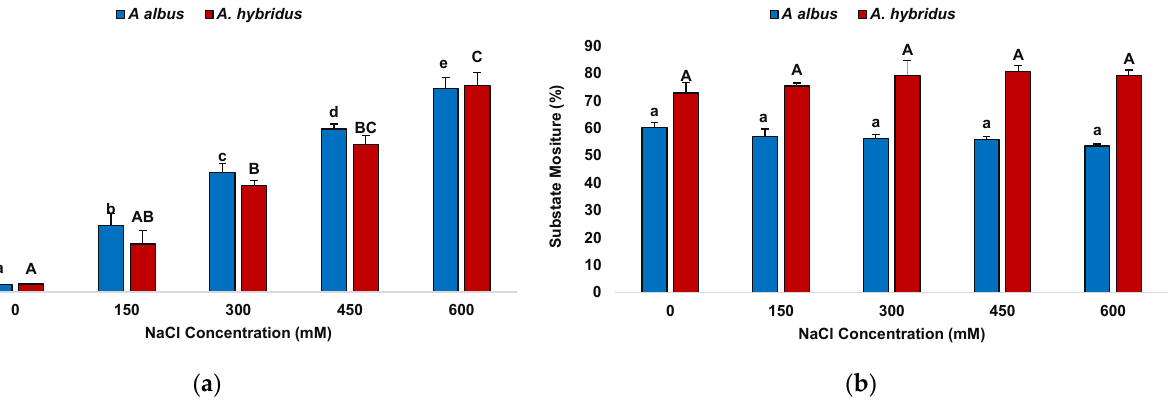
Figure 4. Electric conductivity (EC 1:5 ) ( a ) and substrate moisture ( b ) measured after one month treat- ment with the indicated NaCl concentrations. Means ± SE, n = 7. Same letters indicate homogeneous groups between treatments for each species, according to the Tukey test ( α = 0.05). Lower-case letters were used for A. albus and capital letters for A. hybridus .